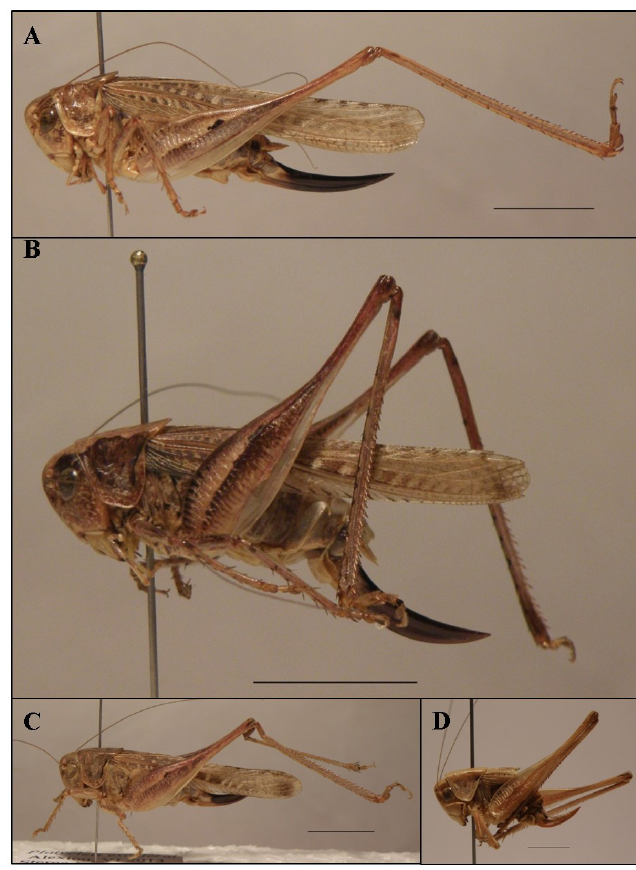
Figure 7. A. Platycleis affinis affinis , female, Kiklades, Andros (scale bar: 10 mm), B . Platycleis grisea , female, Mt. Kitheron (scale bar: 10 mm), C . Platycleis escalerai escalerai , female, Attiki, Vravrona (scale bar: 10 mm), D . Incertana incerta , female, Attiki, Vravrona (scale bar: 5